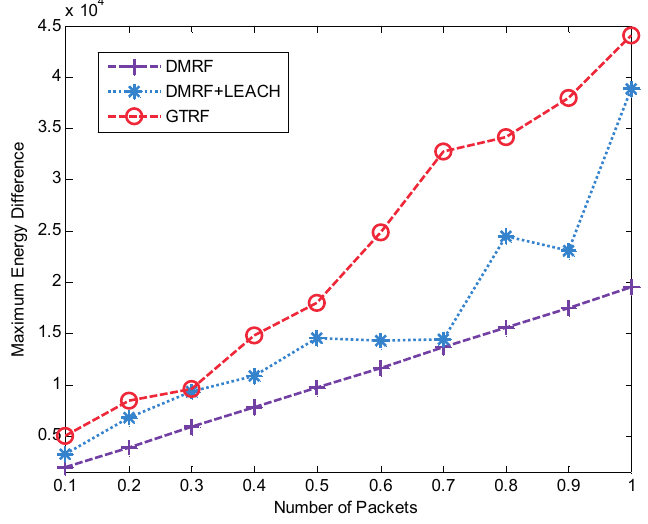
Figure 10. Lifetime of the network with selfish